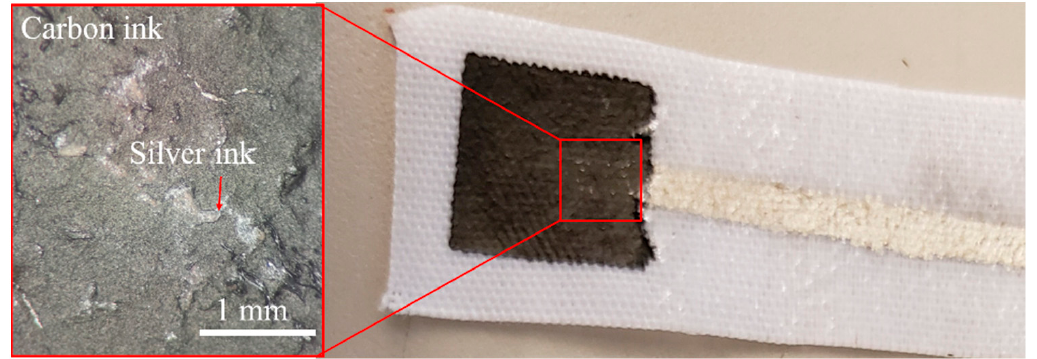
Figure 7. Textile SPE design with silver conductive trace extending past plastisol cover and under the carbon trace and close-up of exposed silver ink under carbon ink.